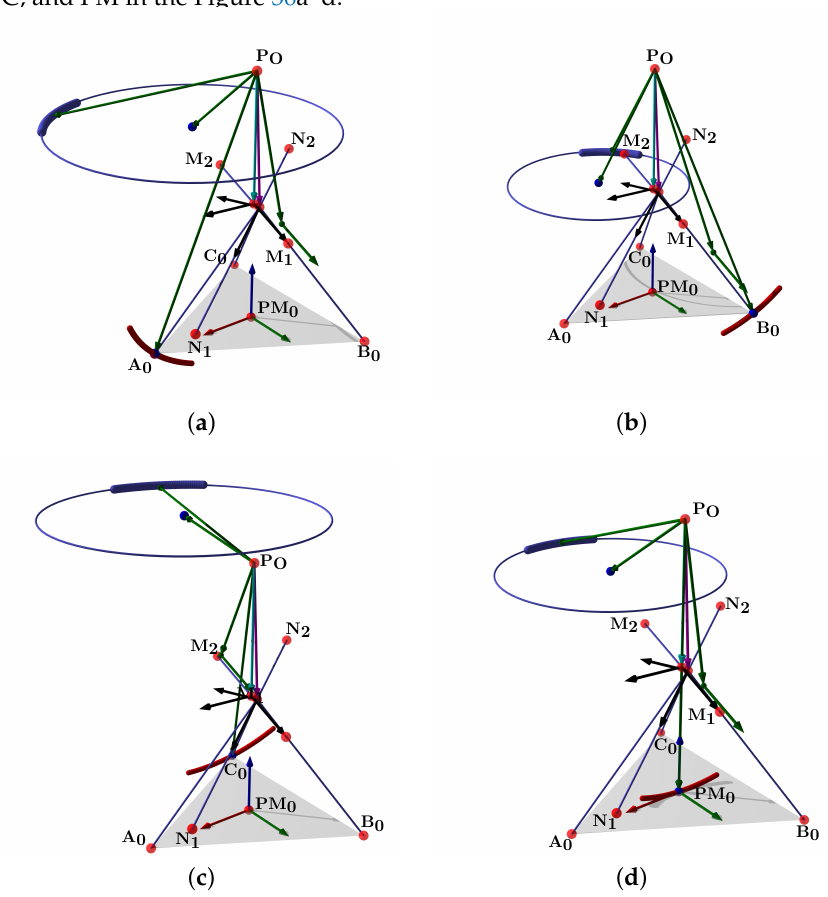
Figure 36. TC axis circle fitting: ( a ) trajectory A, ( b ) trajectory B, ( c ) trajectory C, ( d ) trajectory